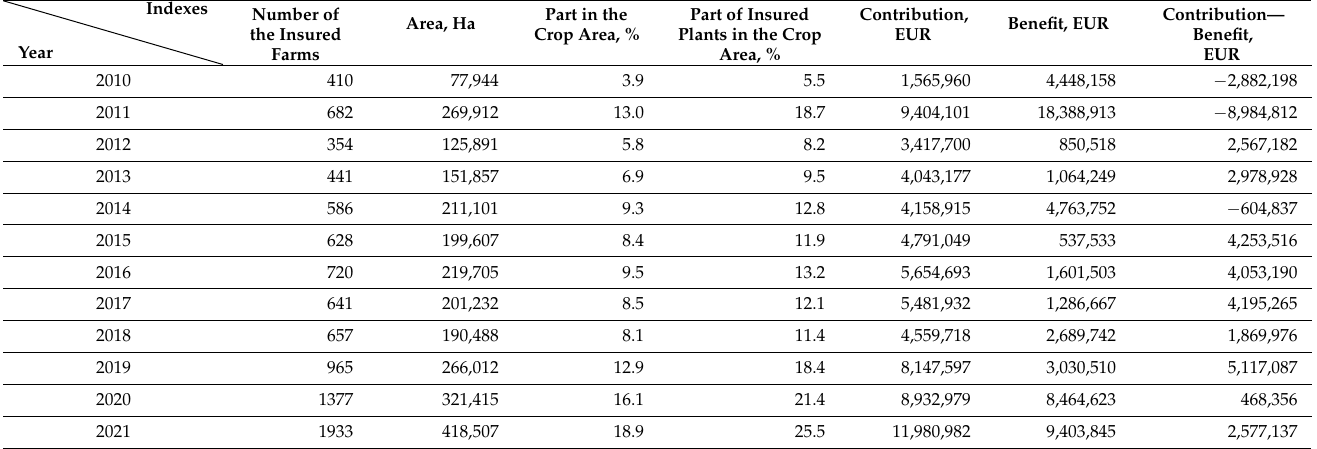
Table 3. Crop Insurance Results of the market in Lithuania